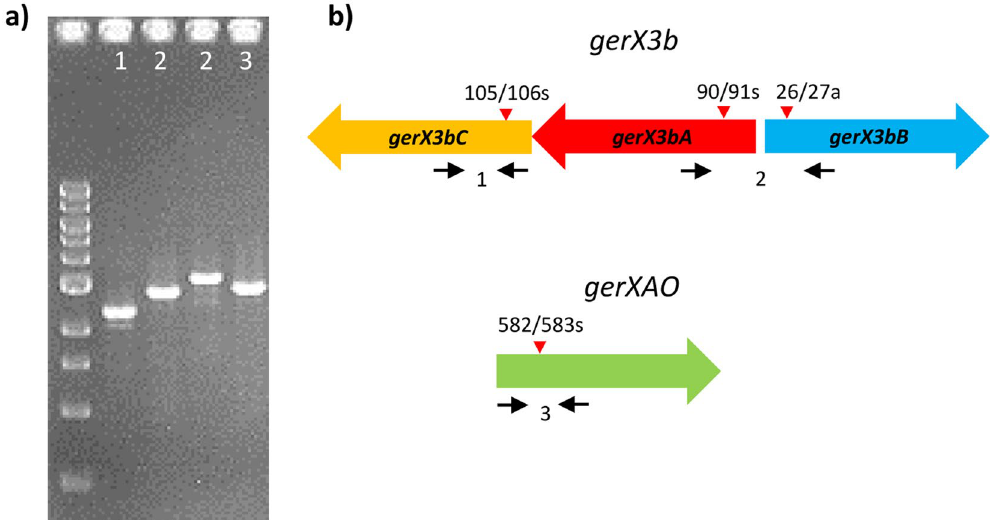
Figure 3. Confirmation of insertional mutagenesis. ( a ) PCR screens of C . botulinum gerX gene mutants confirming that the intron has successfully inserted into the target gene. Numbers represent primer sets used. Gel image has been cropped, full image available in supplementary figure (S1). ( b ) C . botulinum germination genes showing Clostron insertion sites (red arrows). Black arrows represent primer annealing sites. Primer set 1 ( gerC -F/R) anneals to the target gene CB17B_RS15160 gerX3bC either side of the intron insertion site and confirms the intron is present in the target gene (expected band size of mutants ~2 kb). Primer set 2 ( gerAB -F/R) anneals to the target gene CB17B_RS15165 gerX3bA and CB17B_RS15170 gerX3bB either side of the intron insertion sites and confirms the intron is present in the target gene. Primer set 3 ( gerAO -F3/R3) anneals to the target gene CB17B_RS12225 gerXOA either side of the intron insertion sites and confirms the intron is present in the target